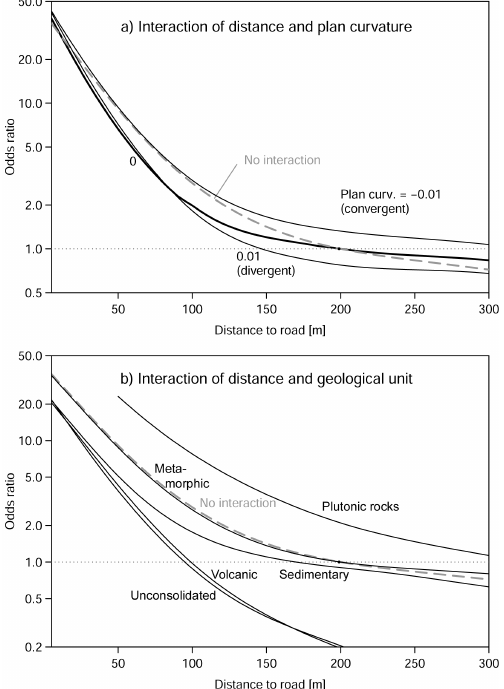
Figure 4. Odds ratio of landslide initiation versus distance to road based on (a) GAMs with interaction between distance and plan cur- vature, and (b) separate GAMs for the different geological units. Odds ratios are relative to the odds at a distance of 200m (black dot) at a straight plan curvature and in geological unit 11, respectively. Grey dashed line: GAM without interaction term for comparison.